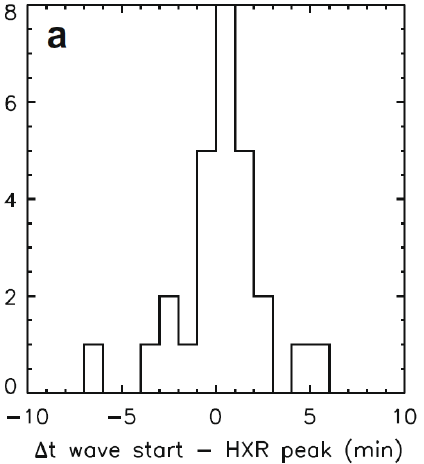
Figure 34: Histogram of the time lag between the first observation of a wavefront and the peak of the associated HXR burst (in minutes). Note that in the majority of events, the wave launch is closely associated with the HXR peak. Image reproduced with permission from Warmuth (2010), copyright by